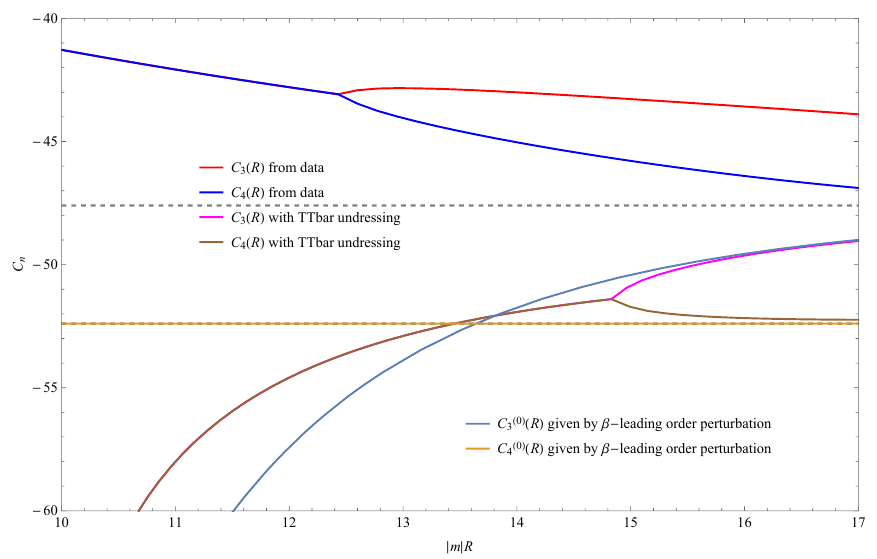
Figure 10 . Fitting of β -contribution to C (0) horizontal axis is ˜ R = R − α 0 E 2 , and the best fit yields β 0 in (2.5).